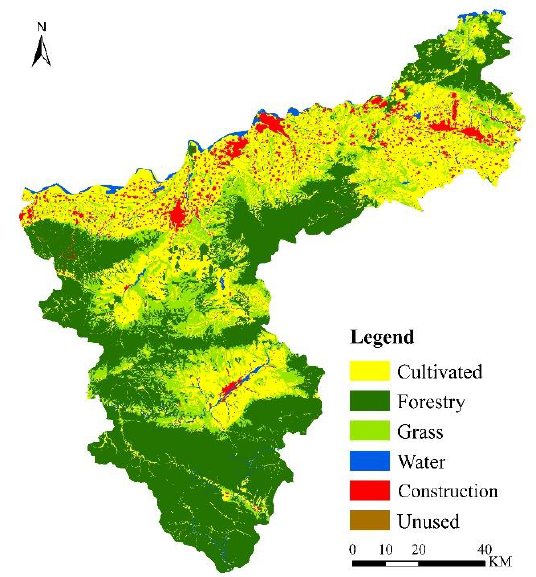
Figure 9. Spatial pattern of optimized land use for 2030.